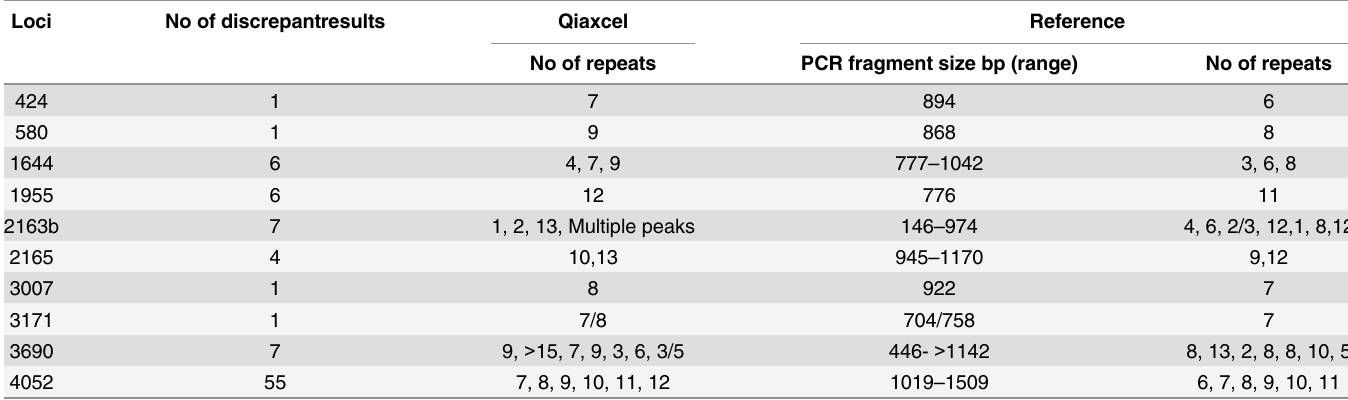
Table 2. Discrepant results for standard loci across two centres.